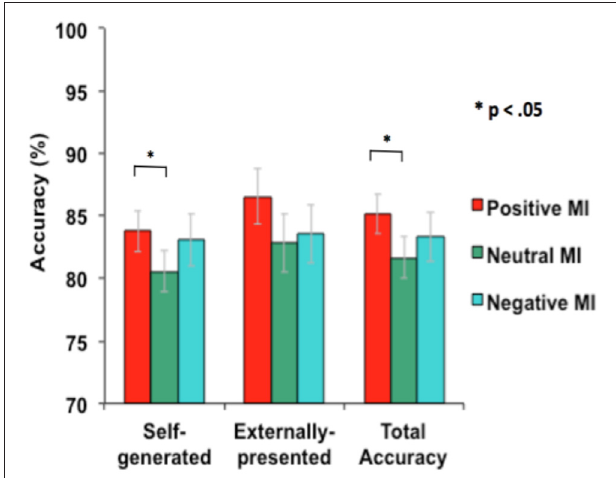
FIGURE 3 | Mean accuracy during reality monitoring task performance for the three types of MI.